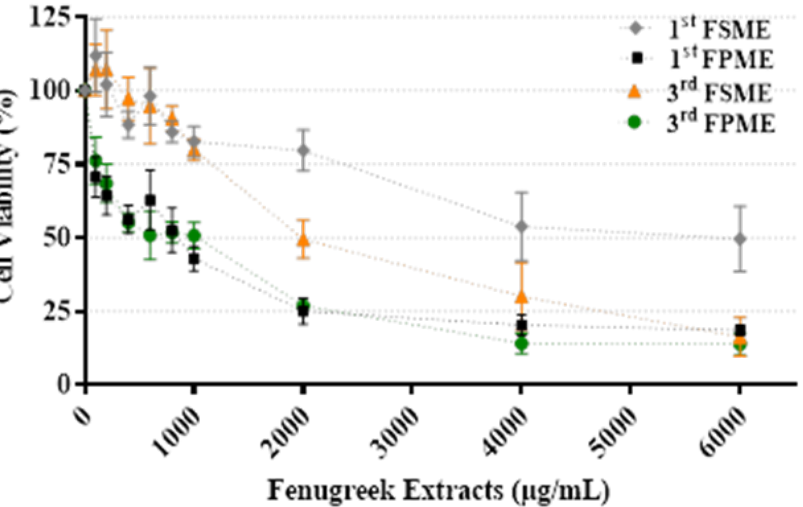
Figure 1. Cell viability of MCF-7 cells treated with various concentrations of fenugreek sprout and seed methanol extracts (0–6000 µ g/mL) for 24 h. 1st Fenugreek Sprouts Methanol Extraction [1st FPME], 3rd Fenugreek Sprouts Methanol Extraction [3rd FPME], 1st Fenugreek Seeds Methanol Extraction [1st FSME], 3rd Fenugreek Seeds Methanol Extraction [3rd FSME]. The values are presented as means n = 6 ± SEM.